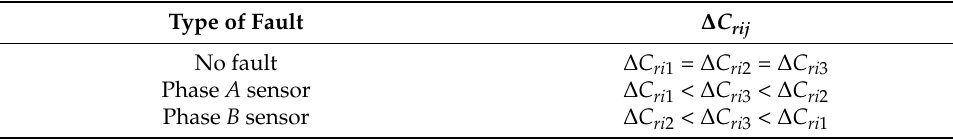
Table 3. It can be also observed that the differences between individual error transients are greater during more influential faults. Table 3. Dependencies between markers under different phase faults.